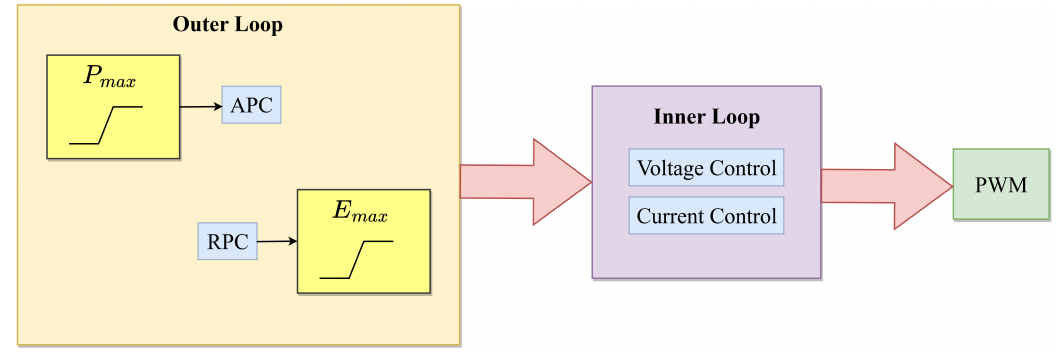
Figure 25. Voltage limiter for the GFM inverter